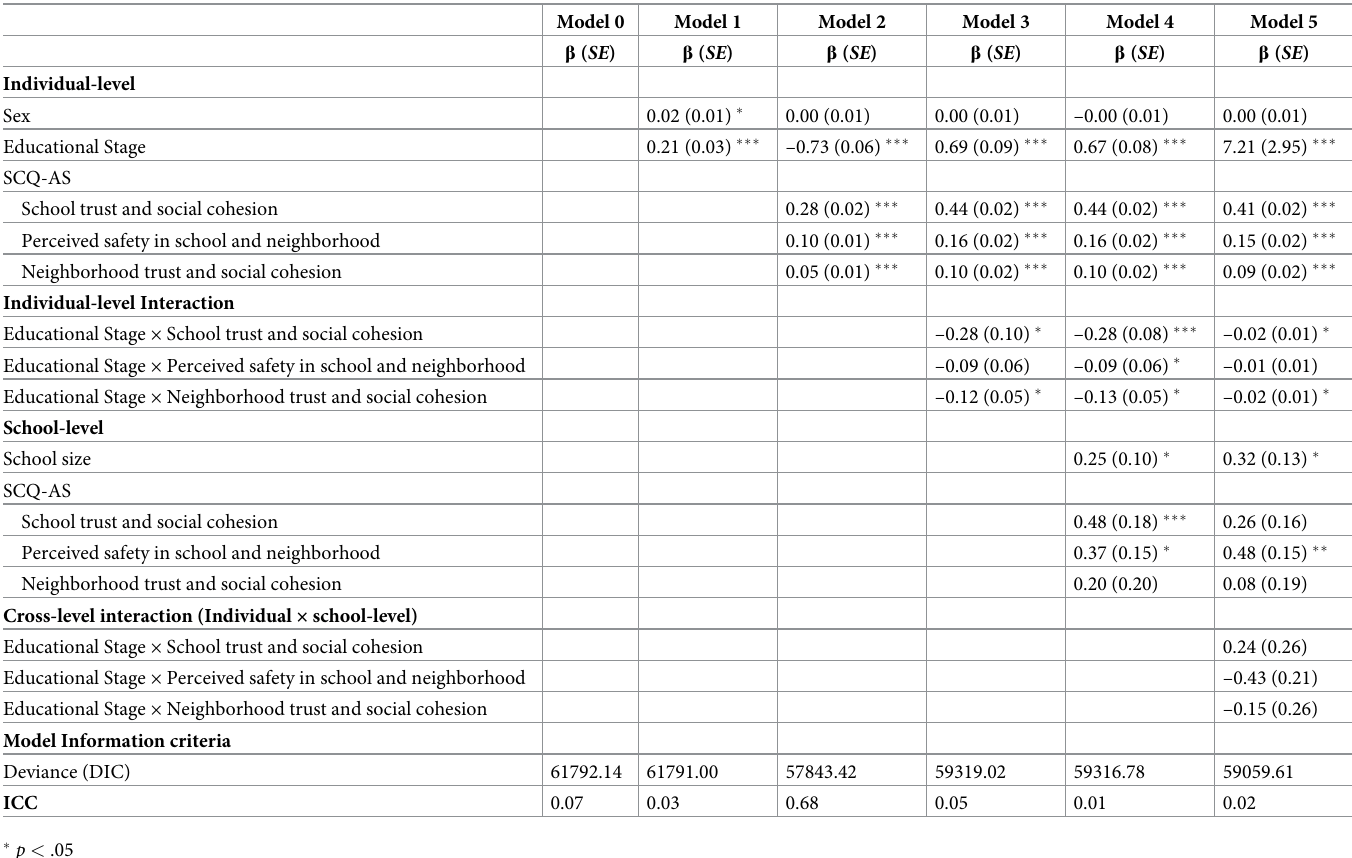
Table 3. Multilevel linear mixed effect model coefficients for